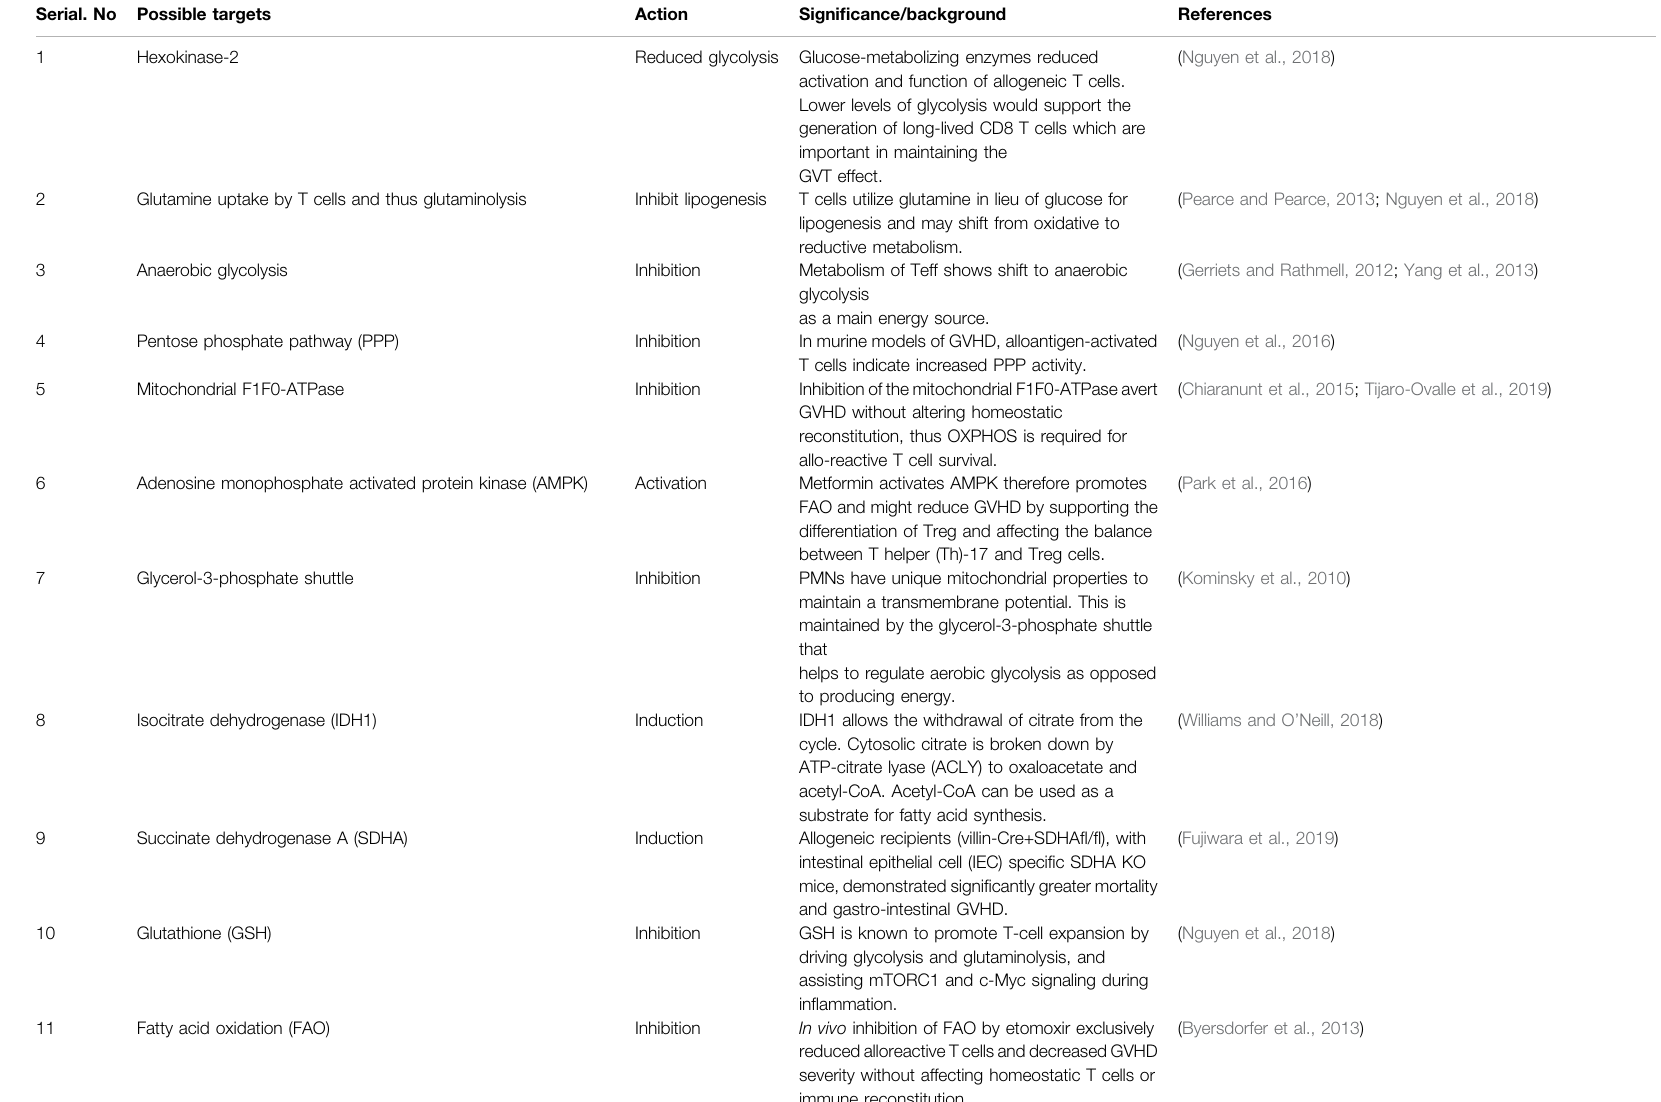
TABLE 1 | Possible potential therapeutic targets used in past or worth to try in